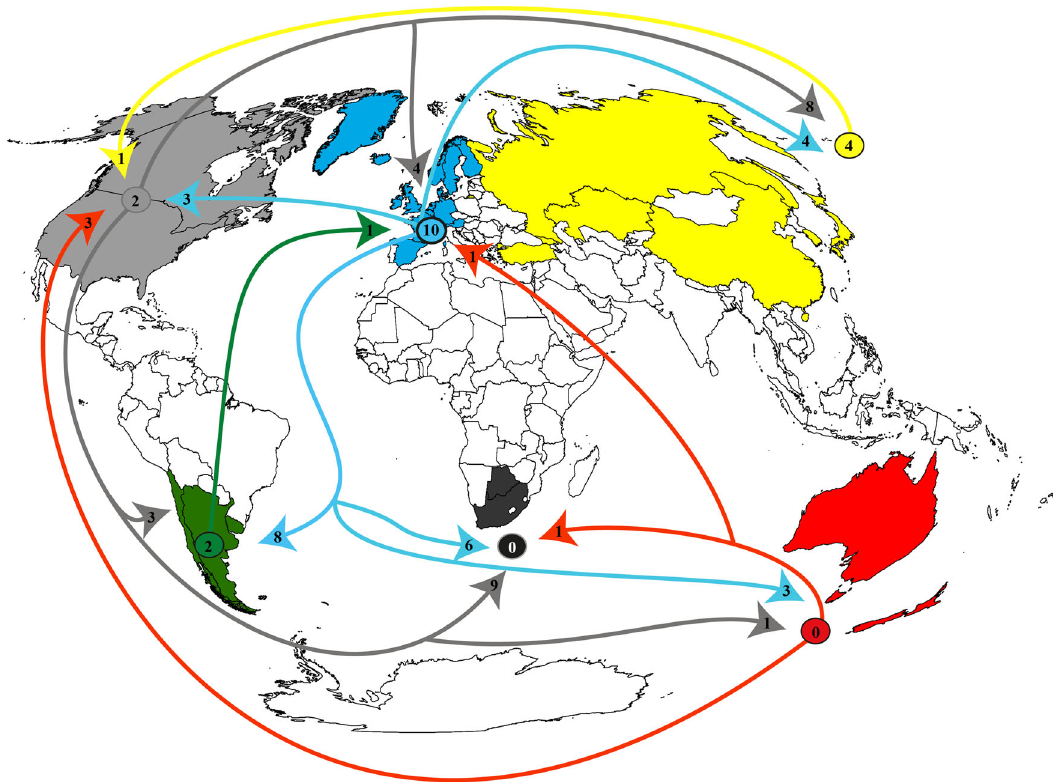
Fig. 4 Exchange of socio-ecological knowledge. The coloured circles show the studies ( n papers) trajecting within continents. The coloured arrows show the number of studies ( n papers) trajecting between the continents, indicating the origin (i.e., fi rst author´s af fi liation) and destination (i.e., location of the study ’ s development) of the socio-ecological knowledge in both